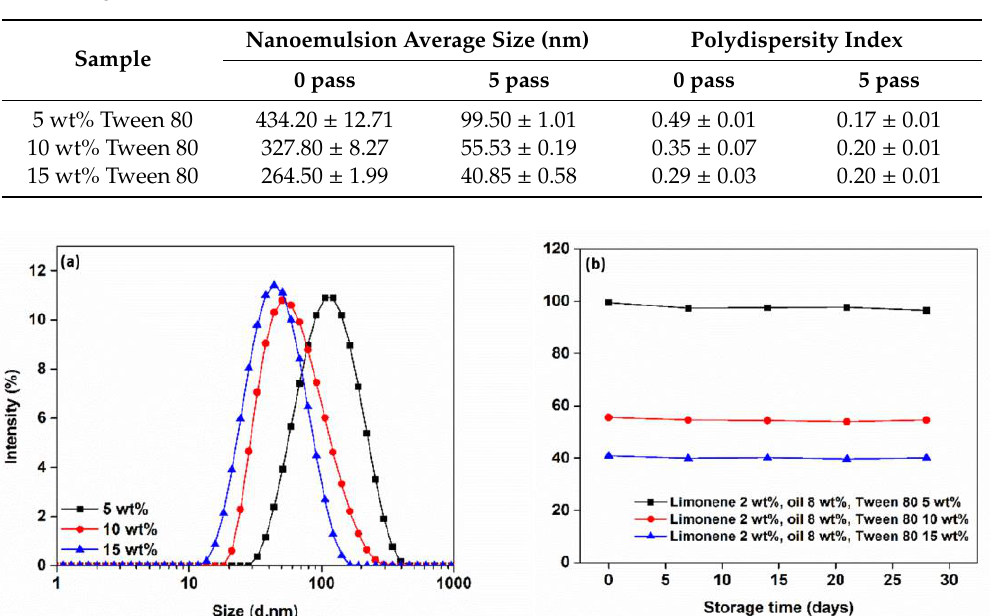
E ff ect of emulsifier on the nanoemulsion size and polydispersity index before and after homogenization.